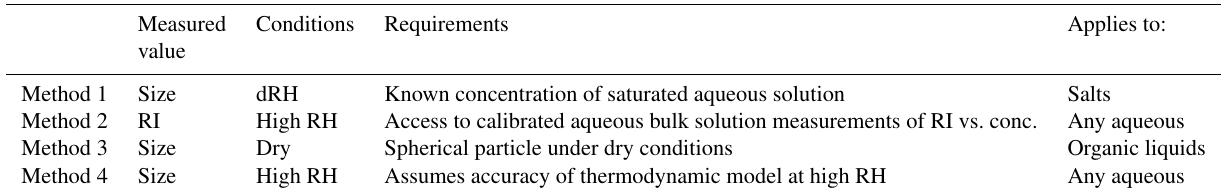
Table 1. Summary of methods to determine the dry size. Measured Conditions Requirements Applies to: Known concentration of saturated aqueous solution Salts High RH Access to calibrated aqueous bulk solution measurements of RI vs. conc. Any aqueous Dry Spherical particle under dry conditions Organic